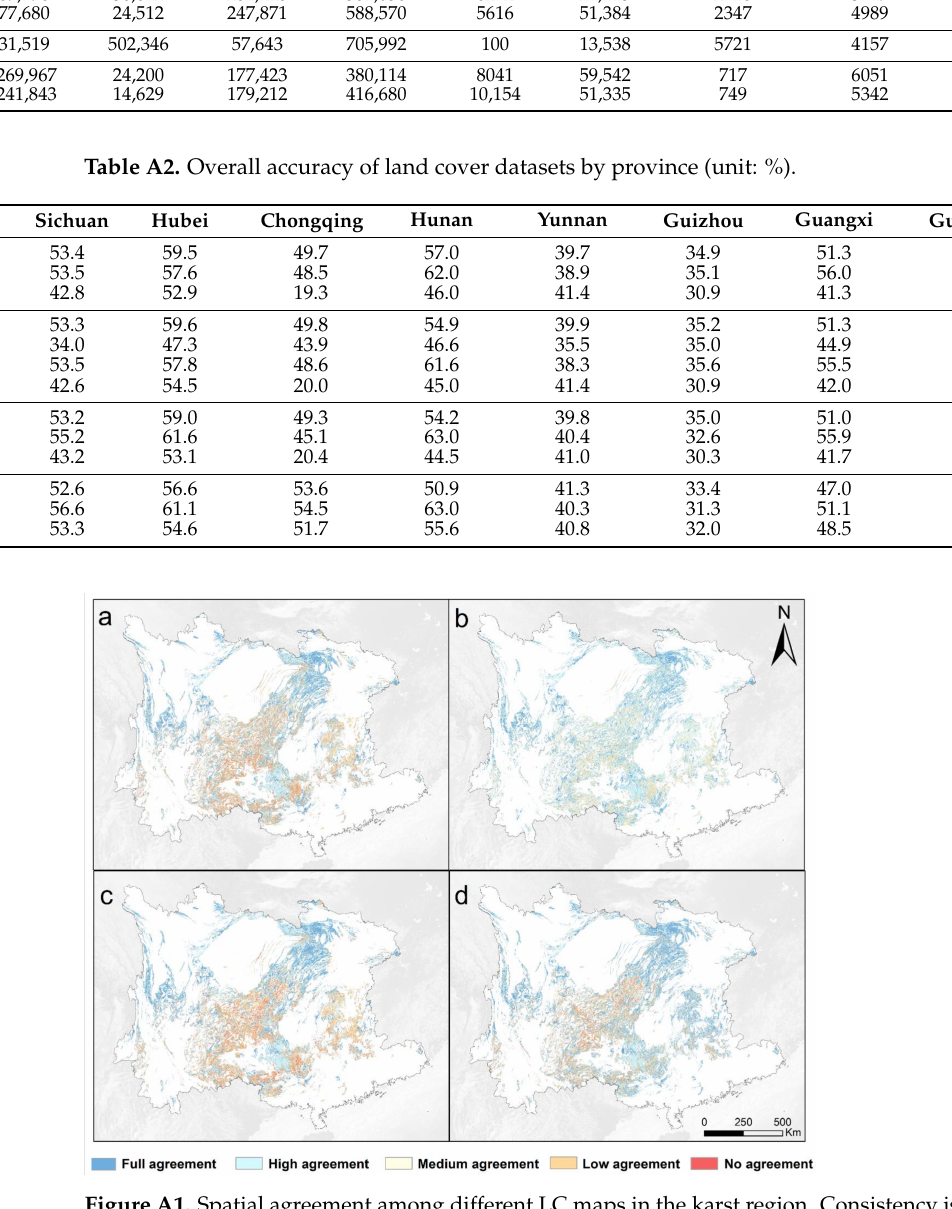
Figure A1. Spatial agreement among different LC maps in the karst region. Consistency is defined by the number of the LC dataset with the same cover type in each pixel for epochs ( a ) 2000, ( b )